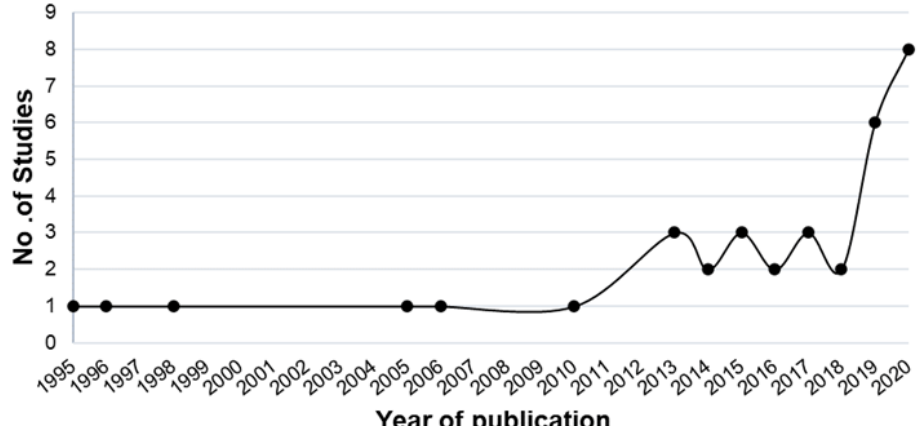
Figure 3. The count of machine learning studies in KC from 1995 to 2020.